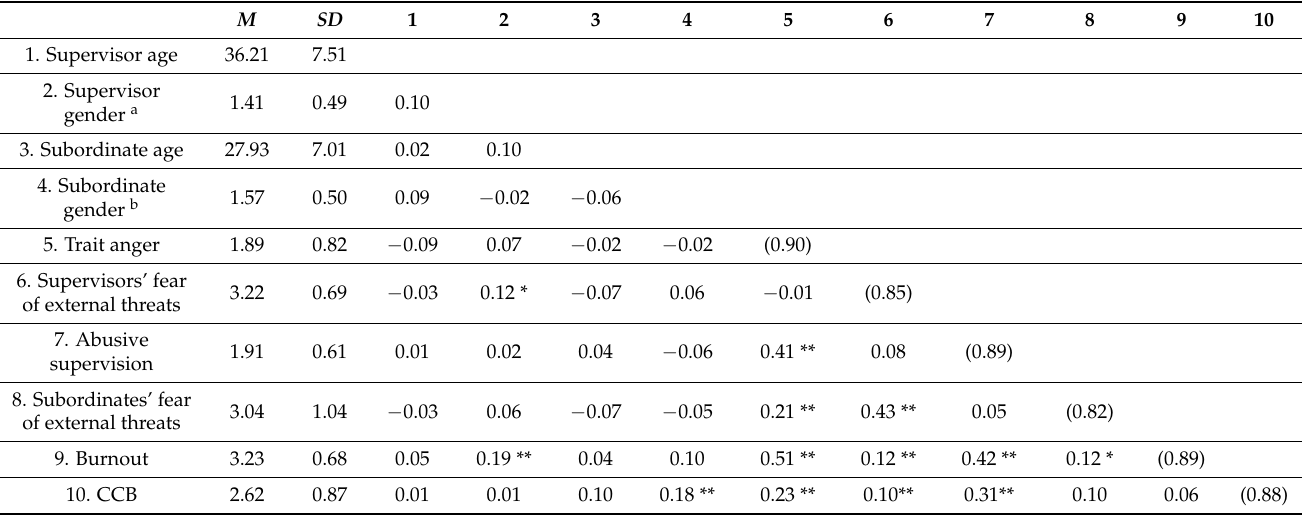
Table 2. Means, Standard Deviations, and Correlations of